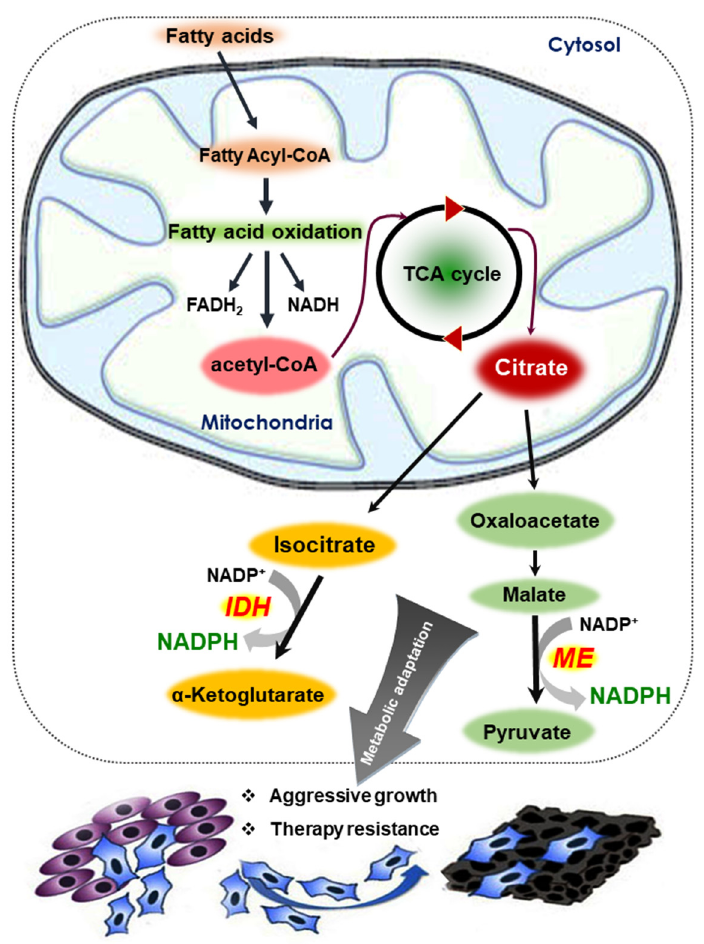
Figure 4. Mechanism of NADPH production from fatty acids. Acetyl-CoA generated as a conse- quence of FAO enters the TCA cycle and generates citrate. After export into the cytosol, citrate is funneled into metabolic reactions catalyzed by the malic enzyme (ME) and isocitrate dehydrogenase 1 (IDH1). During these reactions, large amounts of NADPH These enzymes ultimately produce are produced. Changes in redox balance within the tumor microenvironment allows cancer cells to become more aggressive and resistant to therapeutic agents.